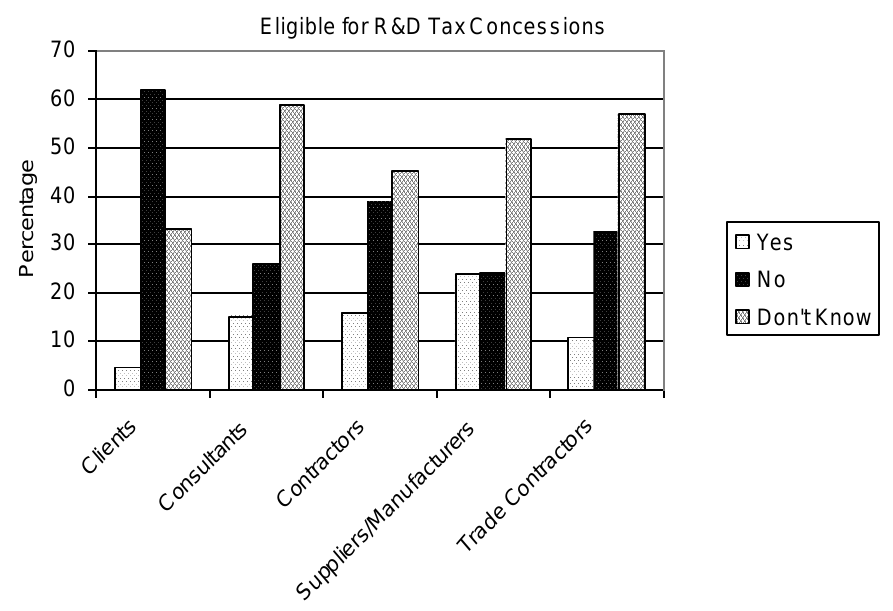
Figure 1: Ability to claim R&D tax